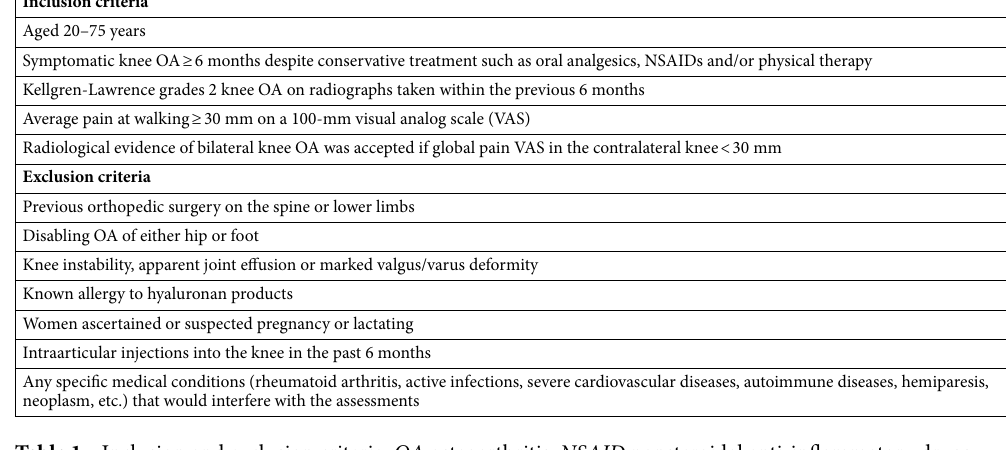
Table 1. Inclusion and exclusion criteria. OA osteoarthritis, NSAID nonsteroidal anti-inflammatory drugs, VAS visual analog